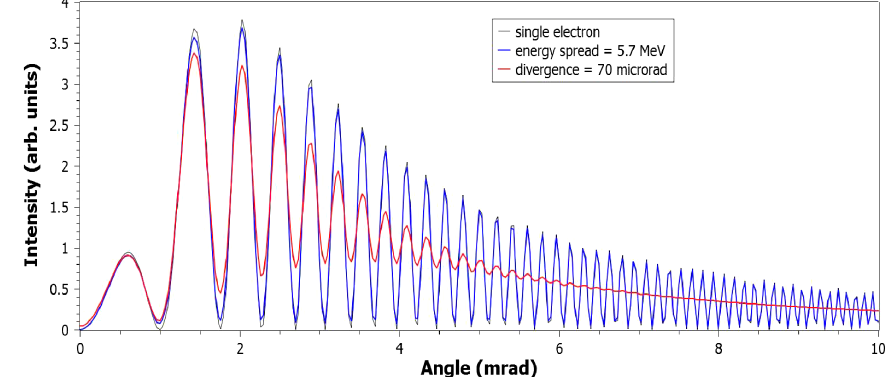
19. OTR interferences from two sources separated by L ¼ 600 mm for a beam with energy 286 MeV; (1) black curve: single electron; (2) blue curve: beam with 2% energy spread; (3) red curve: beam with angular spread (divergence) equal to 70 μ